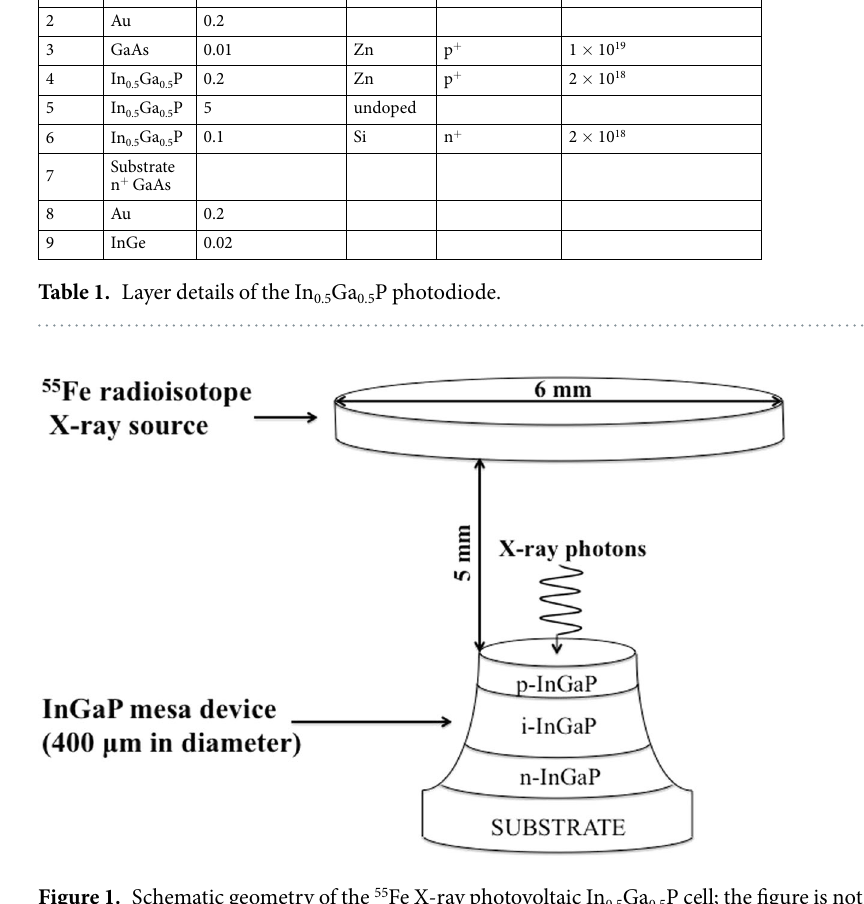
Figure 1. Schematic geometry of the 55 Fe X-ray photovoltaic In 0.5 Ga 0.5 P cell; the figure is not drawn to